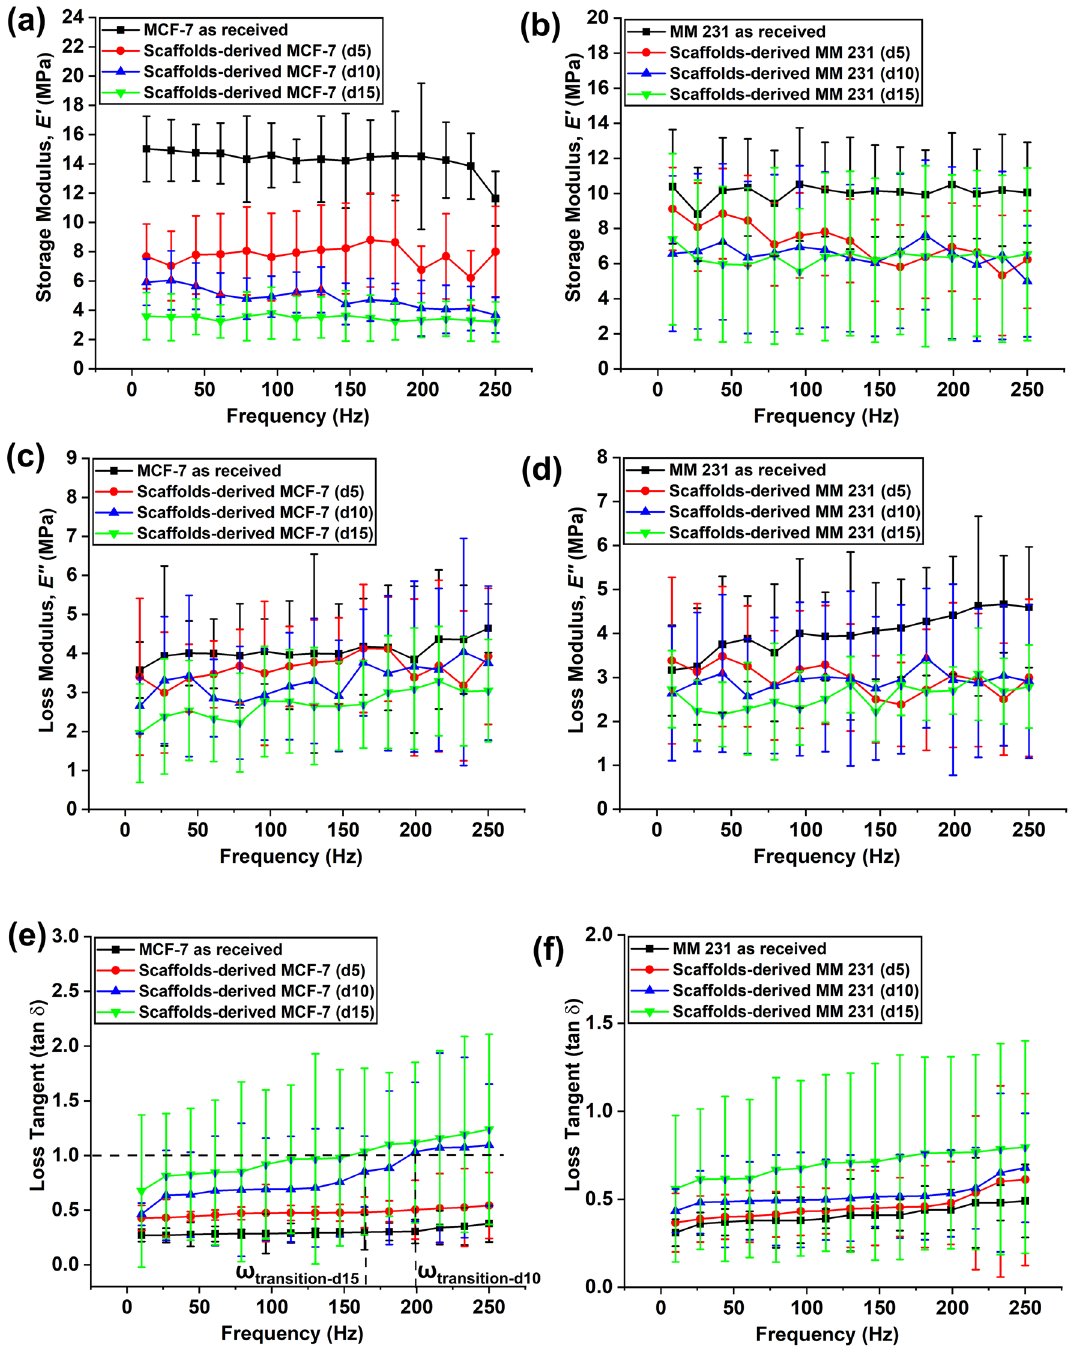
Figure 4. Variation of storage modulus ( E ′ ) for (a) MCF-7 as received and 3D bone-mimetic scaffolds-derived MCF-7 cells; (b) MM 231 as received and 3D bone-mimetic scaffolds-derived MM 231 cells. Variation of loss modulus ( E ′′ ) for (c) MCF-7 as received and 3D bone-mimetic scaffolds-derived MCF-7 cells; (d) MM 231 as received and 3D bone-mimetic scaffolds-derived MM 231 cells. Variation of loss tangent (tan δ) for (e) MCF-7 as received and 3D bone-mimetic scaffolds-derived MCF-7 cells; (f) MM 231 as received and 3D bone-mimetic scaffolds-derived MM 231 cells. Intersections with the horizontal dashed line at tan δ = 1 of the vertical lines occur at transition frequencies, ω transition